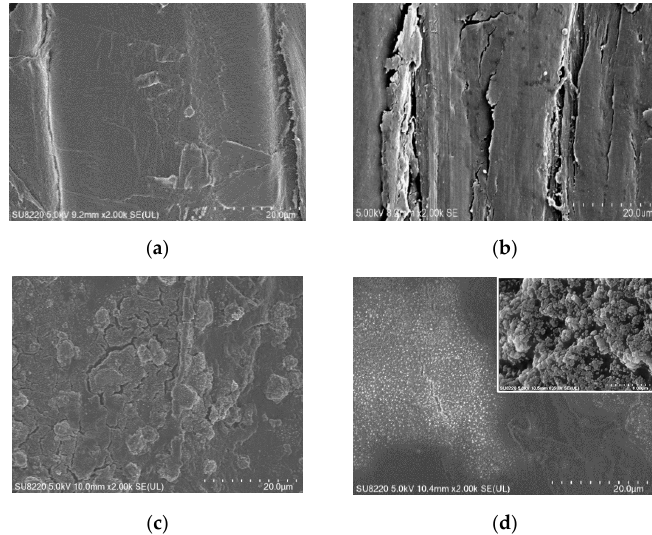
Figure 5. SEM images of wood samples. ( a ) Original wood (2 × 10 3 ); ( b ) Wood@PDA (2 × 10 3 ); ( c )